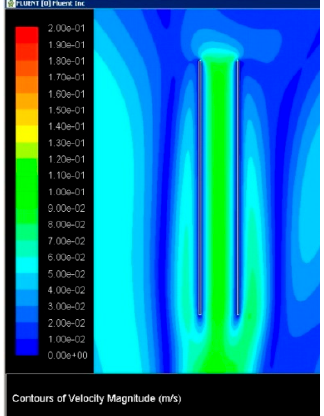
Figure 18. The contours of velocity (m/s) at spacing of 10 mm and rib height 70 mm. Table 2. Calculated isothermal cooling performance for